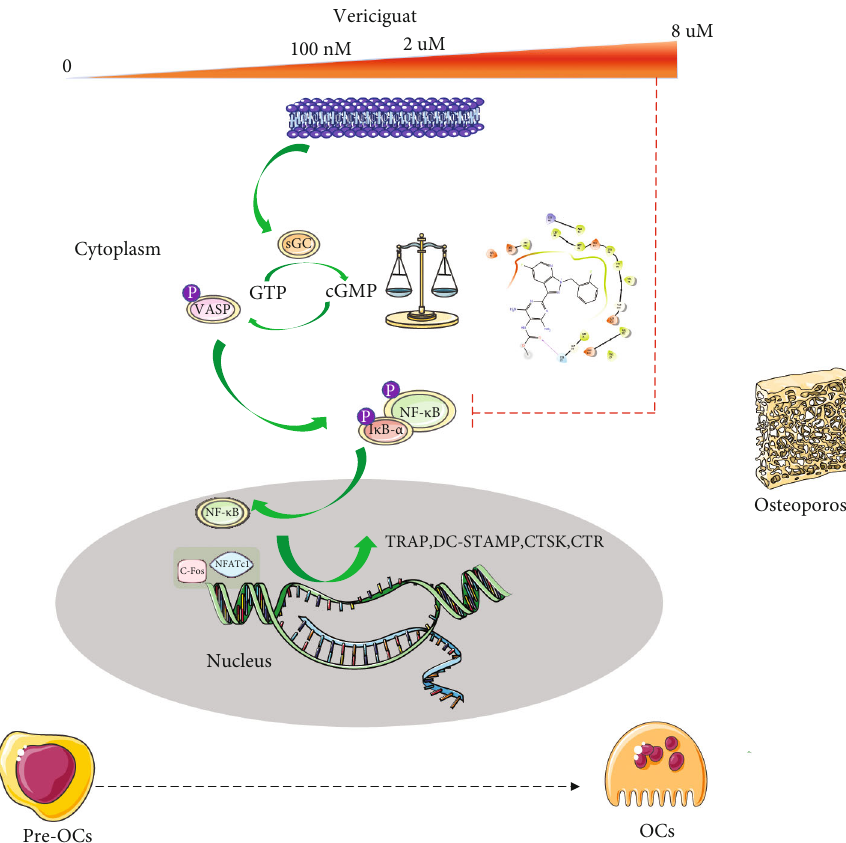
Figure 8: Dual e ff ect of Vericiguat on RANKL-induced osteoclastogenesis and molecular mechanism. There may be a potential balance between the I κ B- α /NF- κ B signaling pathway and sGC/cGMP/VASP in BMMs. Vericiguat at low doses (0-2 μ mol/l) enhanced RANKL- induced osteoclastogenesis dominantly through upregulation of the VASP/I κ B- α /NF- κ B signaling pathway, whereas Vericiguat at high doses (4 or 8 μ mol/L) suppressed RANKL-induced osteoclastogenesis through directly inhibiting the I κ B- α /NF- κ B signaling pathway signaling cascade, which could disturb VASP-mediated activation of the I κ B- α /NF- κ B signaling